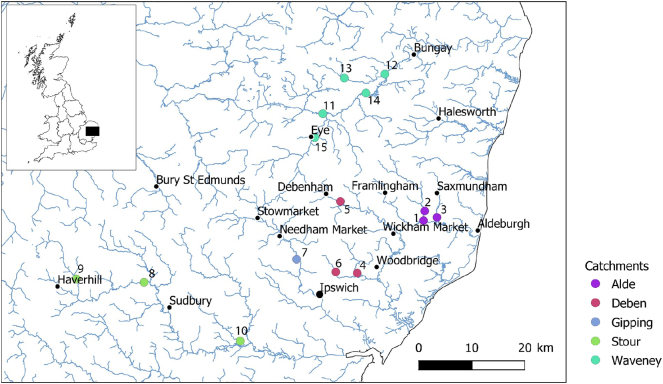
Sampling locations of collected biota and surface water samples within the respective river catchments of Suffolk. Black dots indicate urbanised areas.